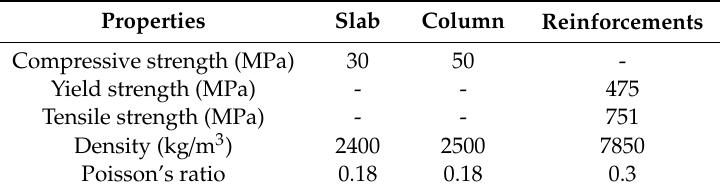
Figure 1. Details of slab-column joints. Table 3. Material properties for analysis.